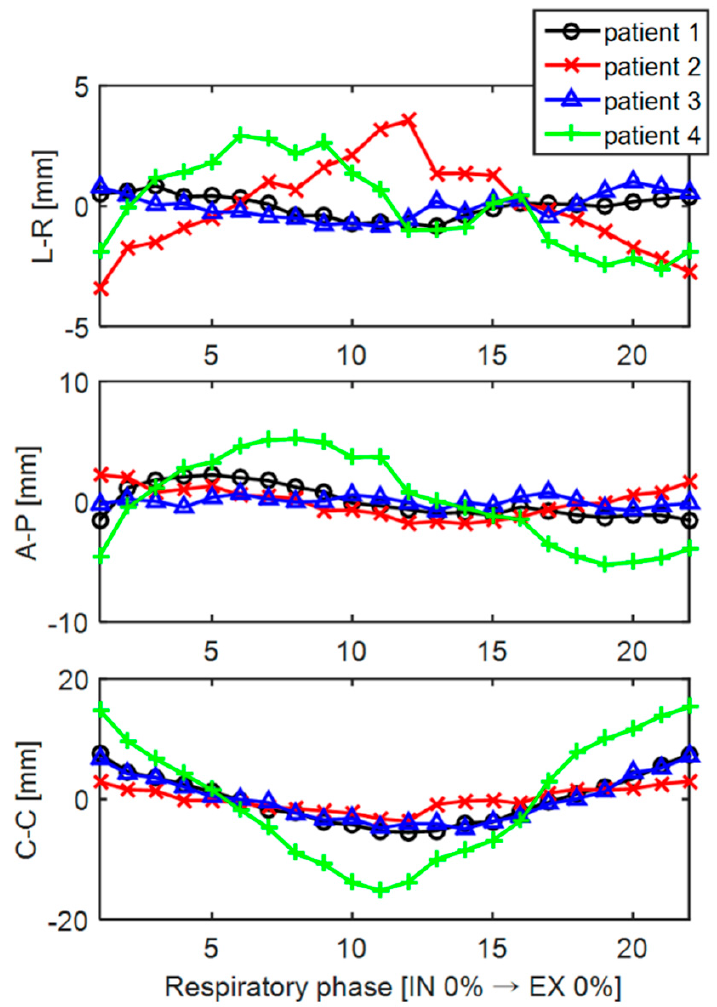
Figure 4. The trajectory of the tumor centroid in 3D along left–right (L–R), anterior–posterior (A–P), and cranial–caudal (C–C) directions over the different respiratory phases for patients 1 through 4.